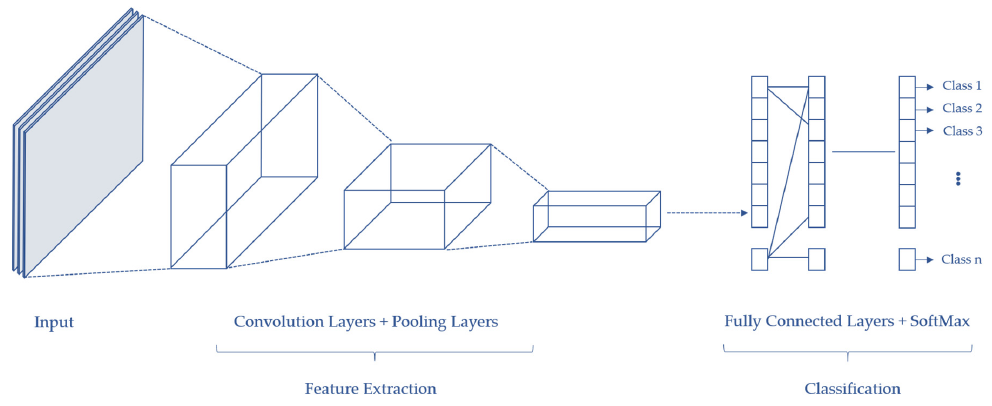
Figure 8. The di ff erent processing layers in a convolutional neural network (CNN) for object detection and identification.